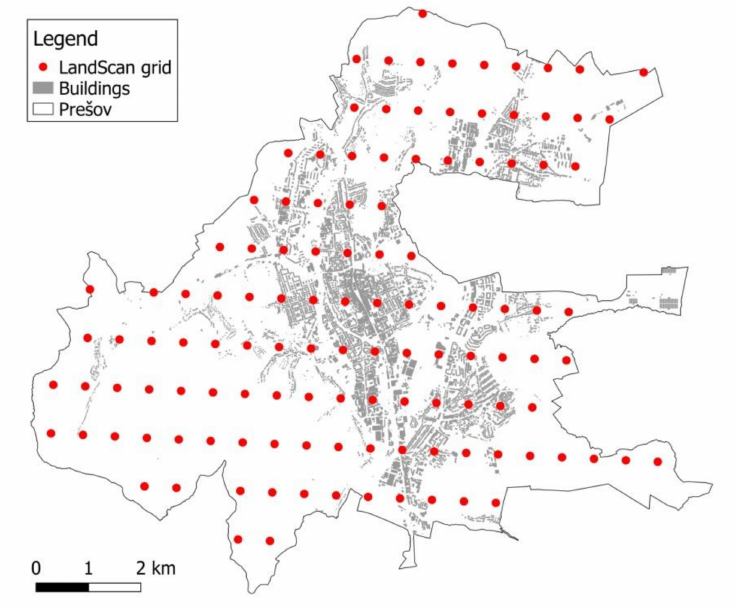
Figure 2. LandScan